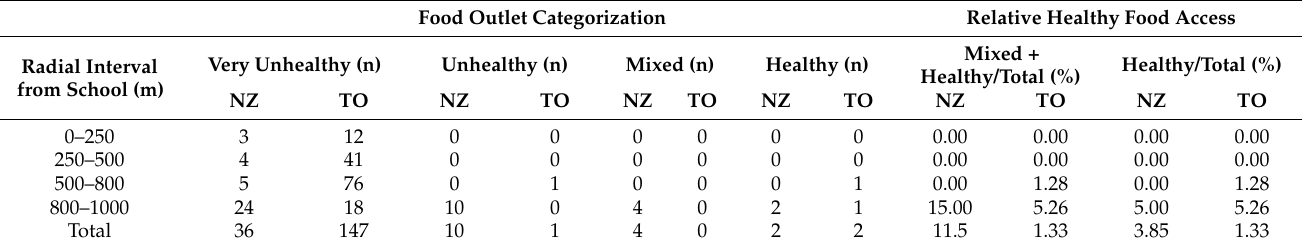
Table 4. Frequency of food outlets and relative healthy food access measure (RHFA); New Zealand (NZ), Tonga (TO).